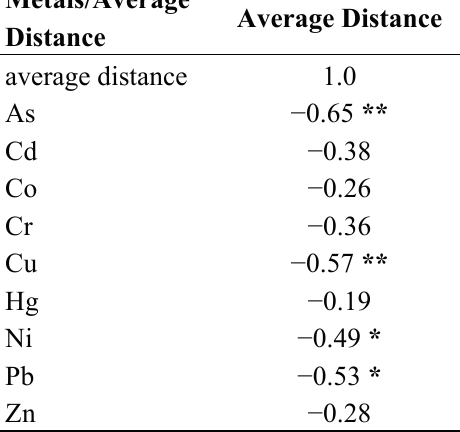
Table 6. Pearson’s correlation matrix of heavy metal concentrations and average distance from the